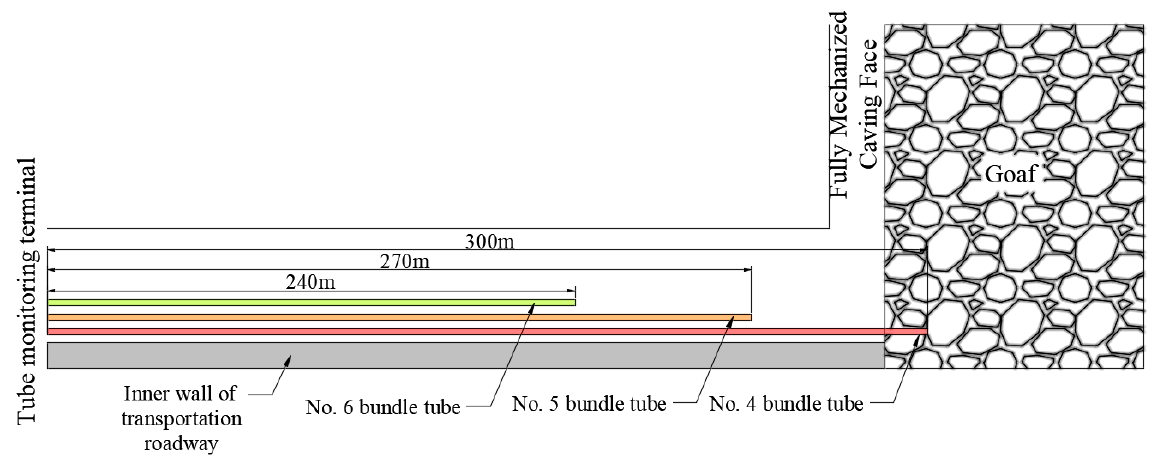
Figure 2. Layout of measuring points in the goaf.